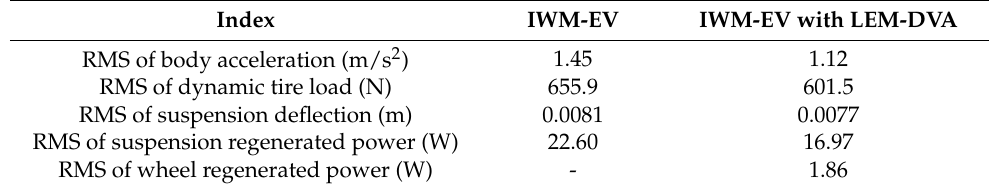
Figure 18. Regenerated power. Table 4. Performance comparison